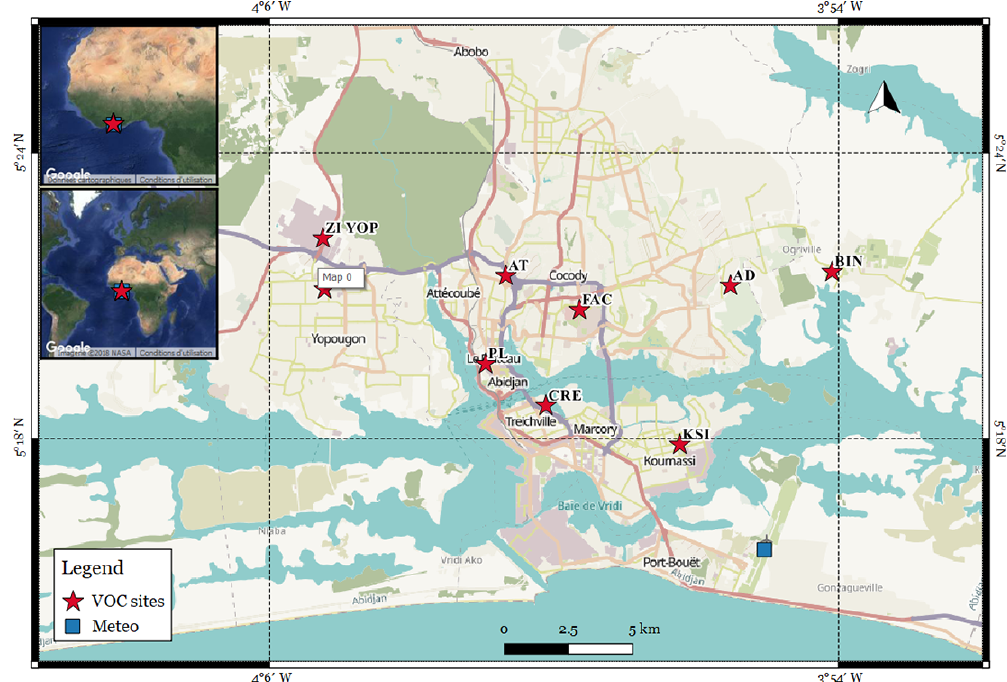
Figure 1. Geographical location of Abidjan, Côte d’Ivoire, and spatial distribution of ambient VOC measurements. Red stars indicate the VOC measurement sites and the blue square represents the meteorology site. More information about the ambient site is detailed in Table 2. Map: © OpenStreetMap contributors (OpenStreetMap contributors,